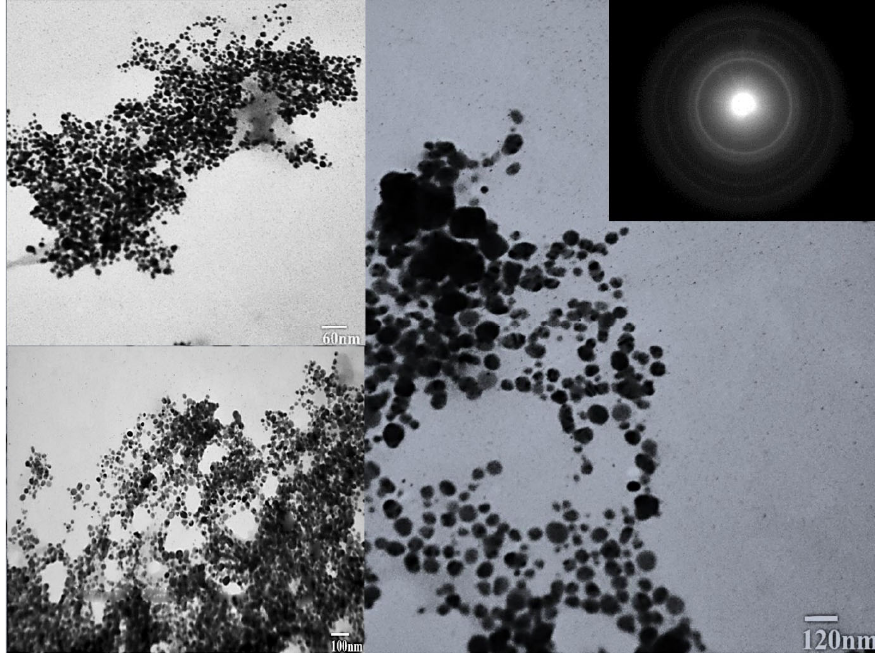
Figure 5. TEM micrographs and SAED pattern of the biosynthesized silver nanoparticles (AgNPs).